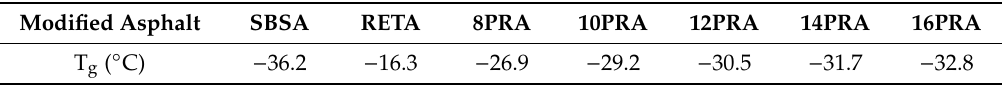
Table 9. Glass transition temperatures of modified asphalts.